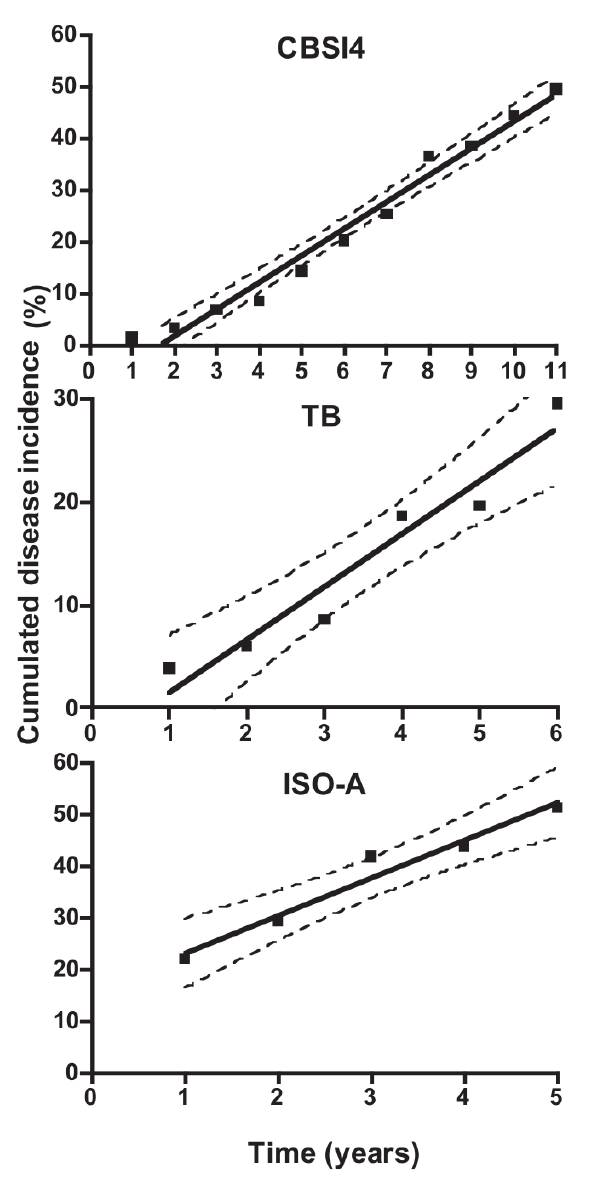
Fig. 2. Increase in cumulated esca incidence (see text for description) over time, estimated in 3 vineyards at Siena (CBSI4; 8-year-old at the beginning of the survey; sur- veyed for 11 consecutive years), Ravenna (TB; surveyed for 6 consecutive years from the year of plantation) and Florence (ISO-A; 13-year-old at the beginning of the sur- vey; surveyed for 5 consecutive years). The fitted lines (straight line) and relative 95% confidence intervals (dot- ted lines) were obtained by linear least square regres- sion analysis (R 2 =0.97, F=343, P <0.0001; R 2 =0.93, F=60.3, P <0.002; R 2 =0.96, F=70.2, P <0.004 for data collected in vineyards CBSI4, TB and ISO-A,